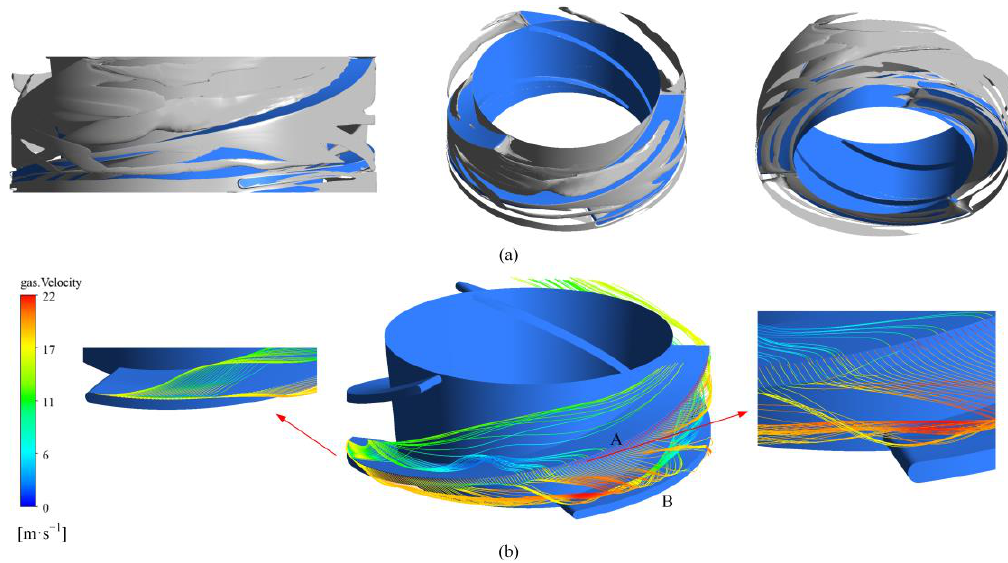
Figure 7. Gas pattern and streamline in the impeller with IGVF of 10%. ( a ) Gas isosurface with a gas volume fraction of 20% and ( b ) streamline of the gas.